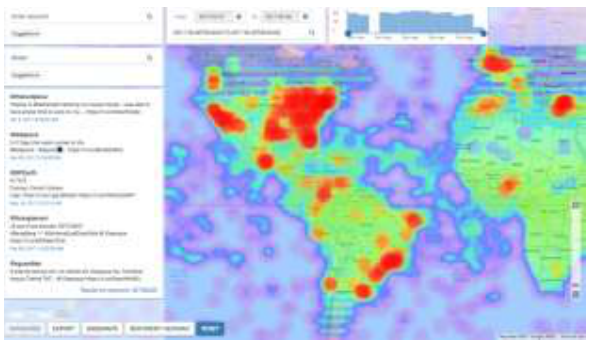
Figure 3. BOP Client